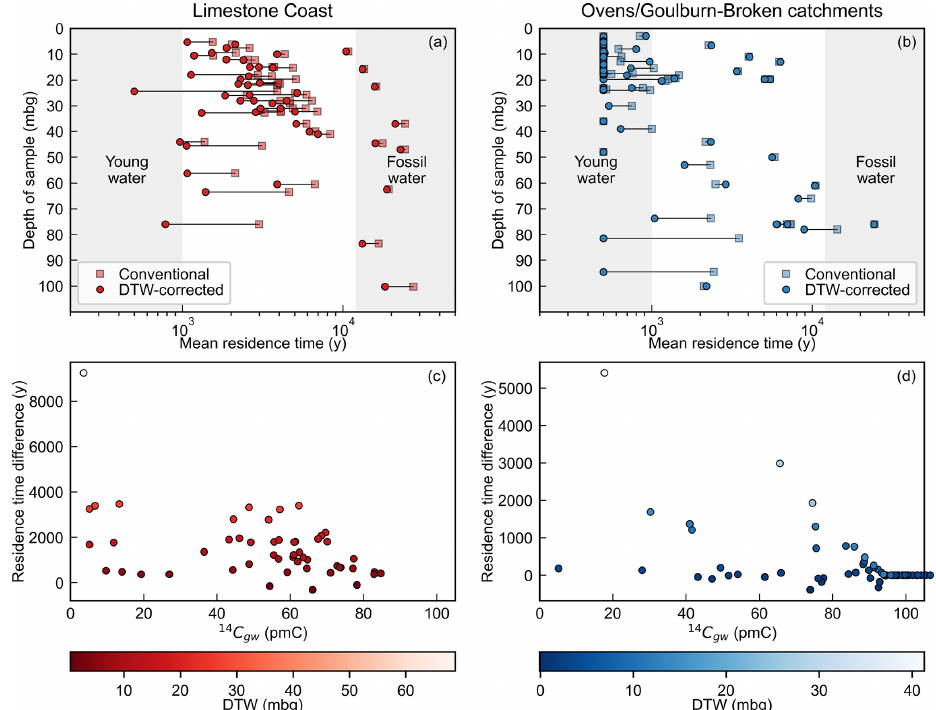
Figure 3. Calculated MRTs for the Limestone Coast (left column, red colours) and the Ovens/Goulburn–Broken catchments (right column, blue colours). Panels (a) and (b) show the difference in calculated MRTs for the uncorrected (Eq. 1, where 14 C i = 100pmC, square markers) and depth-corrected 14 C i values (circle markers). Panels (a) and (b) use definitions of young water of ≤ 1000 years (e.g. Cartwright et al., 2020) and fossil water of ≥ 12000 years (Jasechko et al., 2017). Panels (c) and (d) show the difference in MRTs between the use of 100pmC and the value calculated in Eq. (2) against the measured 14 C activity in groundwater ( 14 C gw ). Marker colours in (c) and (d) are based on the depth to the water table (mbg) when the sample was